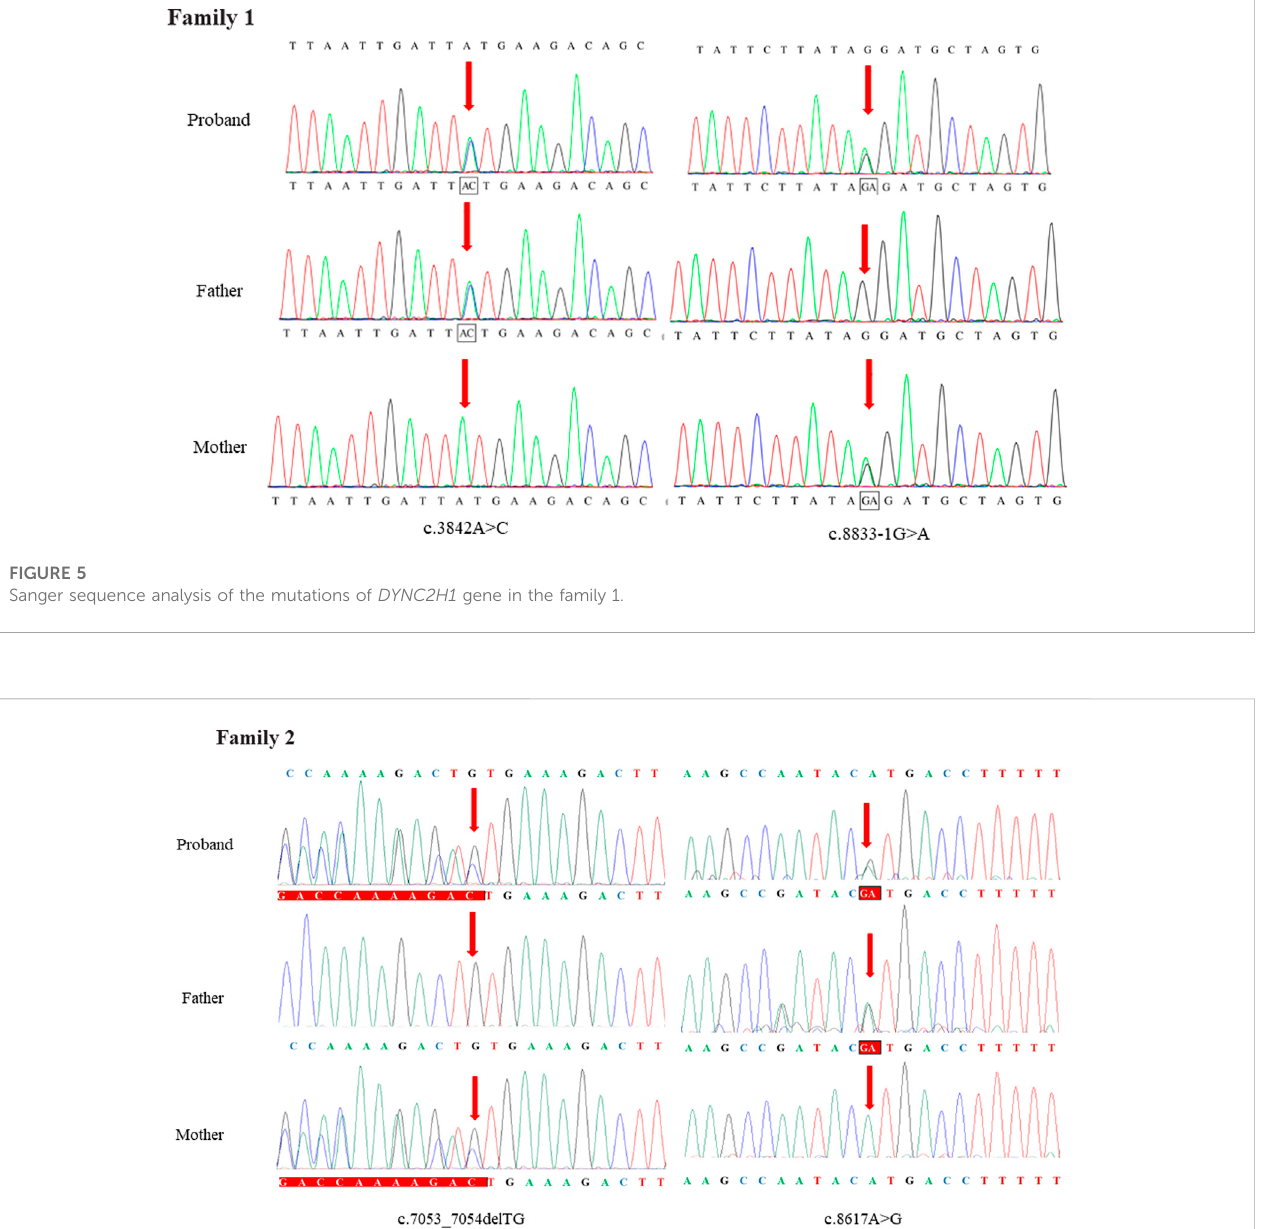
Figure 10A depicted the speci fi c positions of these eight variants in